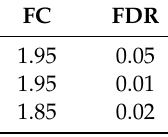
FC, fold change; FDR, false discovery rate.